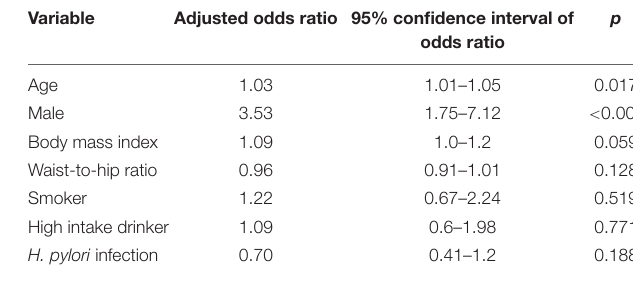
TABLE 3 | Factors associated with clinically significant endoscopic findings: multivariate